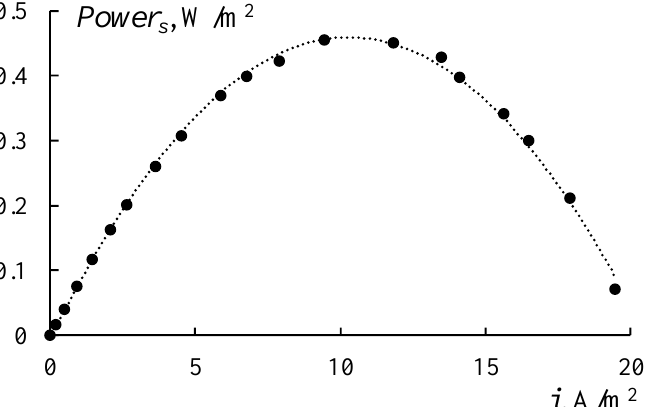
Figure 5. The dependence of the power density of the RED stack on the current density.